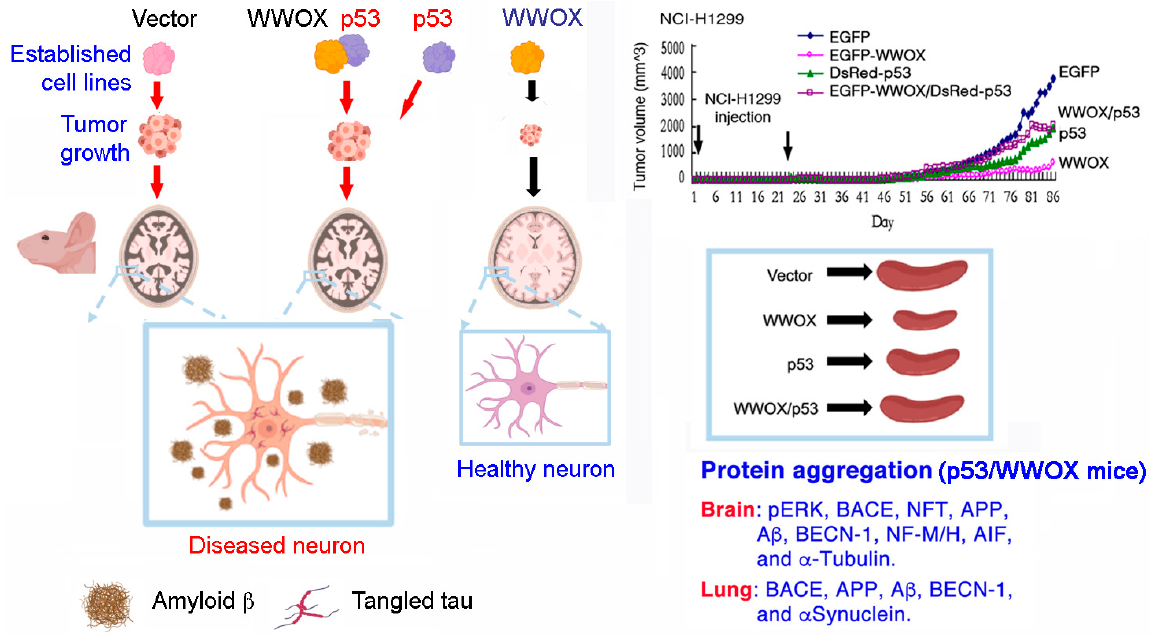
Figure 3. p53 may functionally antagonize the biological functions of WWOX in vivo. Four stable transfectants of NCI-H1299 cells with vector only, WWOX, p53, or WWOX/p53 mammalian expression vectors, were established [76]. Subcutaneous inoculation of these established cells in nude mice revealed that WWOX is most effective in cancer suppression and inhibition of inflammation (splenomegaly), as compared to p53 [76]. p53 inhibits the effect of WWOX in blocking cancer growth. Protein aggregates, including pERK, BACE, APP, A β , NFT, and α -tubulin, are found in the brains of p53/WWOX-NCI-H1299 mice, but not in other mice. Protein aggregates in the lung are also observed.